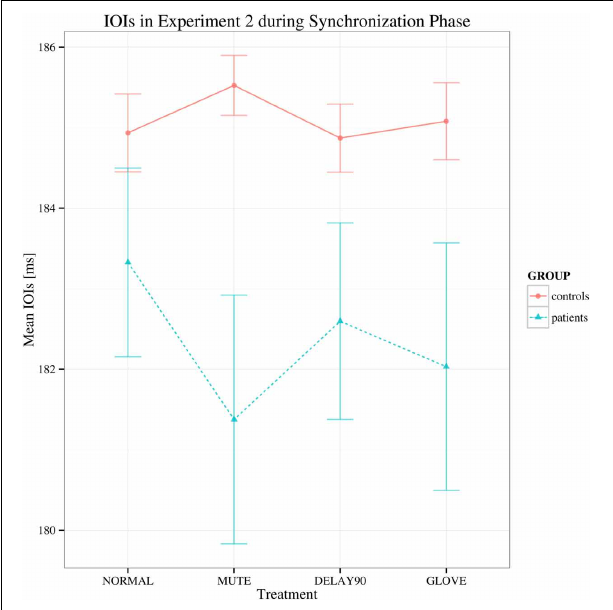
FIGURE 3 | Mean of the mean deviations from the metronome in the synchronization phase in Experiment 2. Shown are the estimated mean IOIs (ms) conditional on group membership and auditory manipulation, collapsed over playing directions. Error bars denote 95% confidence intervals.